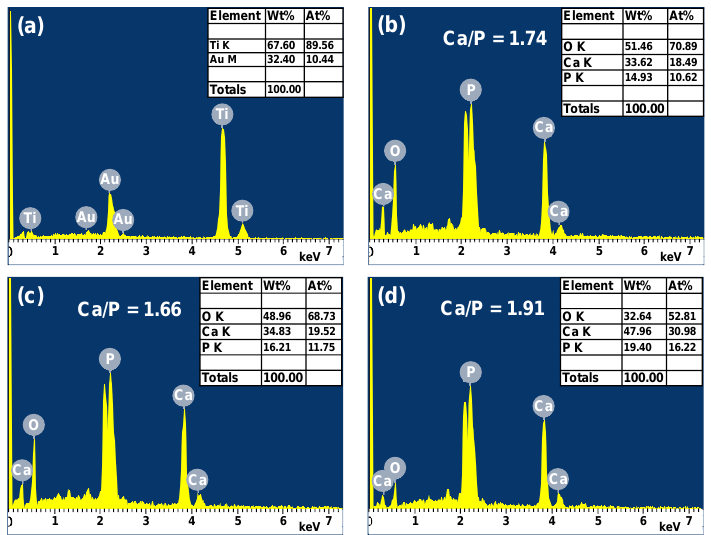
Figure 13. XRD analysis results for ( a ) Ti substrate, ( b ) 330 V, ( c ) 390 V, and ( d ) 450 V coatings after soaking in SBF for 7 days (applied current: 0.6 A, duration time: 5 min).